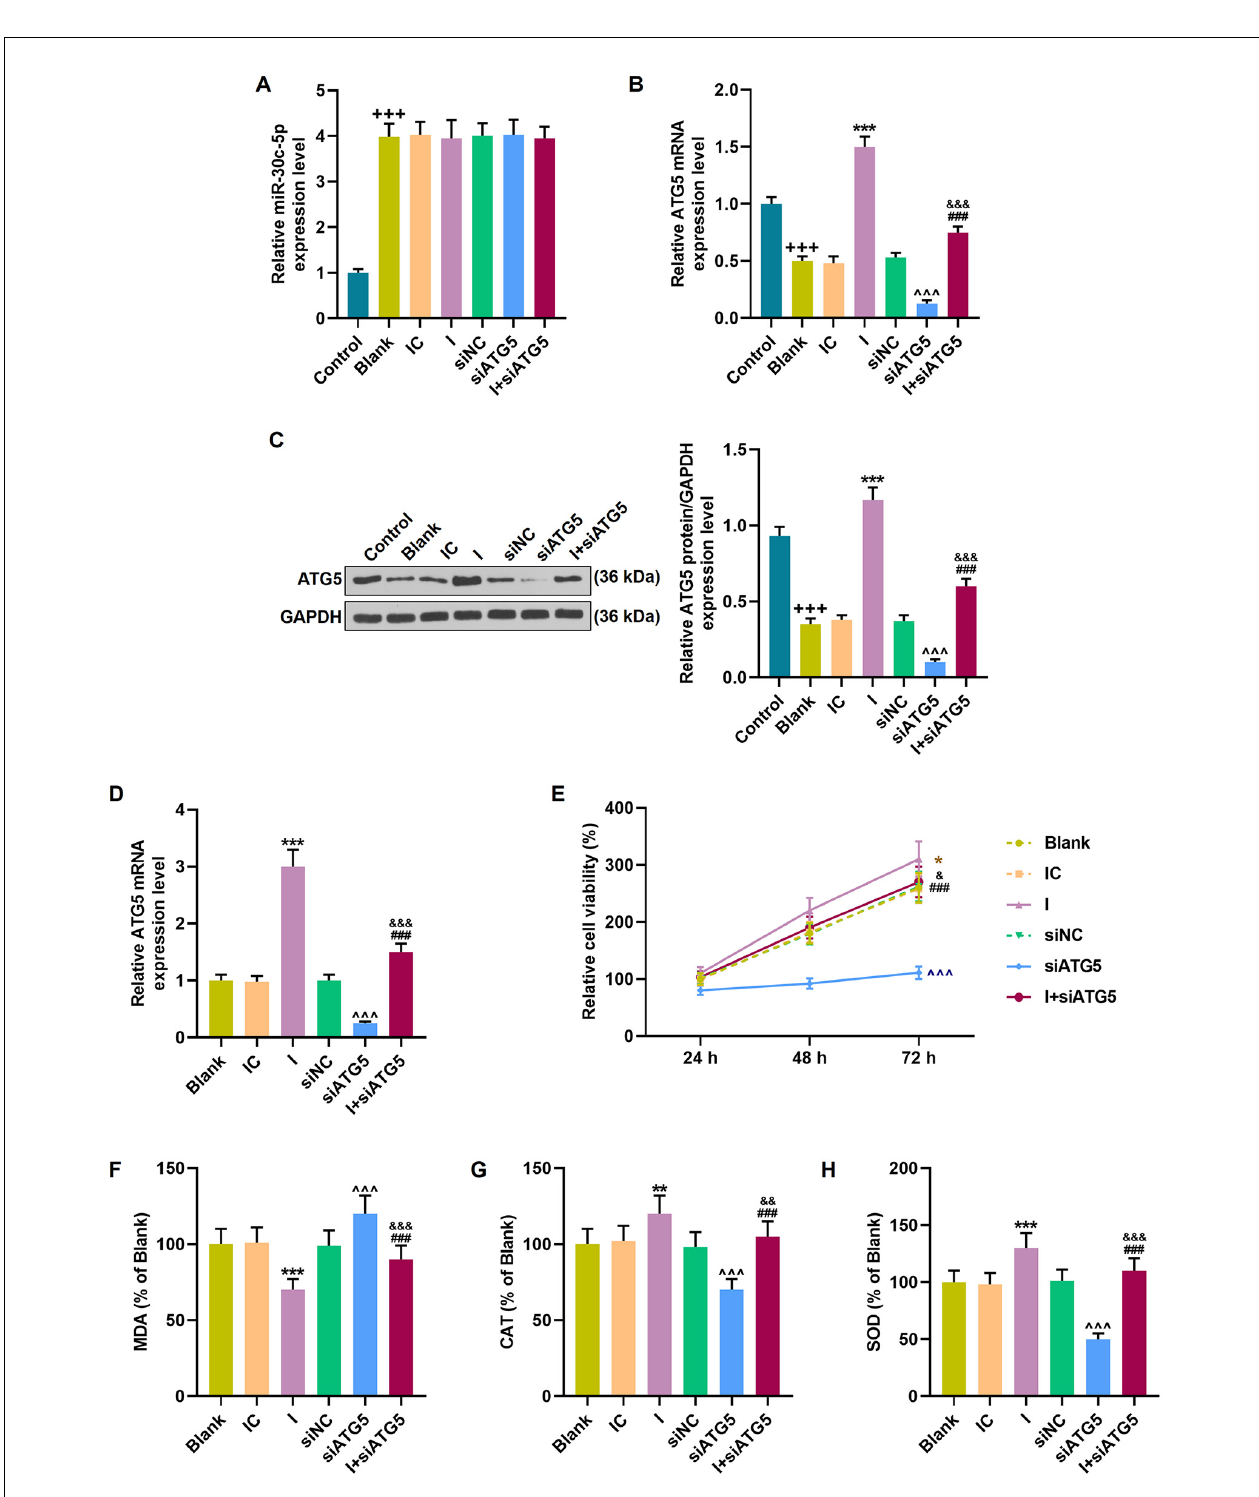
FIGURE 6 | MiR-30c-5p inhibitor regulated cell viability and the levels of oxidative stress-related factors in MPP+ stimulated SH-SY5Y cells via ATG5. (A) qPCR analysis of miR-30c-5p expression in MPP+ induced PD cells. U6 snRNA served as an internal control. (B–D) ATG5 expression in SH-SY5Y cells was detected by Western blot. GAPDH served as an internal control. (E) The viability of SH-SY5Y cells was measured by MTT assay. (F–H) The levels of oxidative stress-related factors MDA, CAT, and SOD were detected. +++ p < 0.001 vs. control. * p < 0.05, ** p < 0.01, *** p < 0.001 vs. IC. ∧∧∧ p < 0.001 vs. NC. & p < 0.05, && p < 0.01, &&& p < 0.001 vs. I. ### p < 0.001 vs. siATG5. NC, negative control for siRNA.